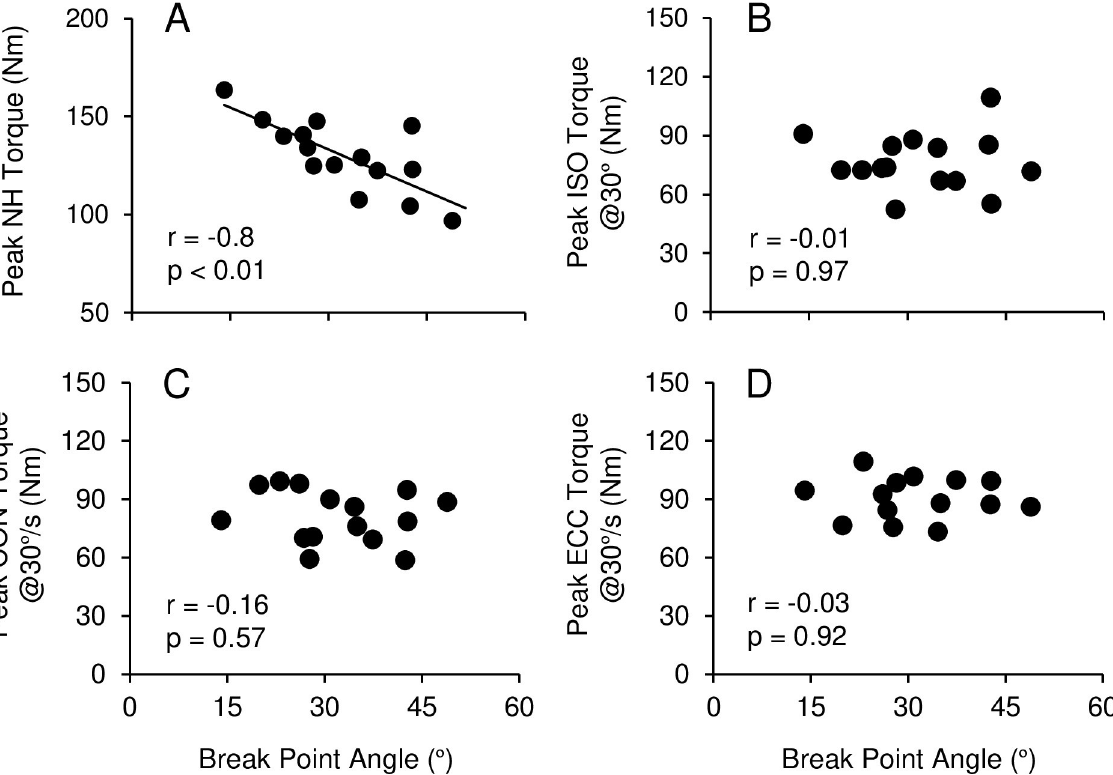
Fig 3. Correlations between break point angle in Nordic hamstring and peak Nordic hamstring torque (A), peak torque in maximal voluntary isometric contraction at 30˚ knee flexion (B), and concentric (C) and eccentric contraction at 30˚/s (D) among 16 study participants. r and p values of Pearson correlation coefficient are shown in each